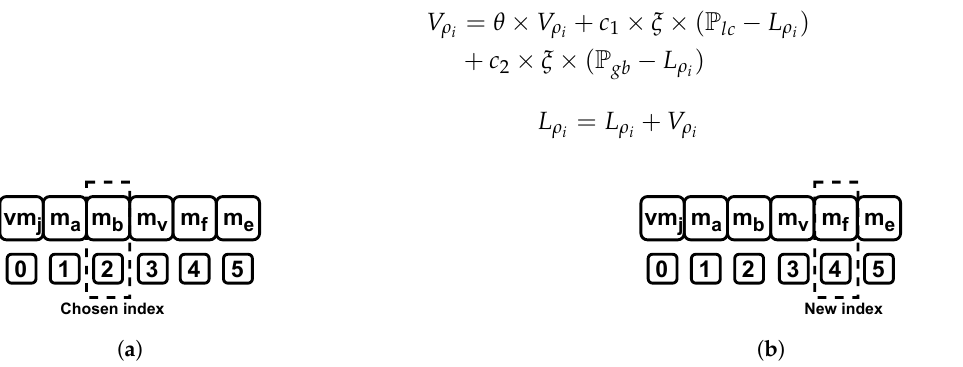
Figure 5. A t i candidate list ( α t ) with 5 edge servers { m a , m b , m v , m f , m e } and one public cloud VM ( vm j ). ( a ) Already i chosen index before updating the location. ( b ) After updating the location considering 2 for V t i ρ